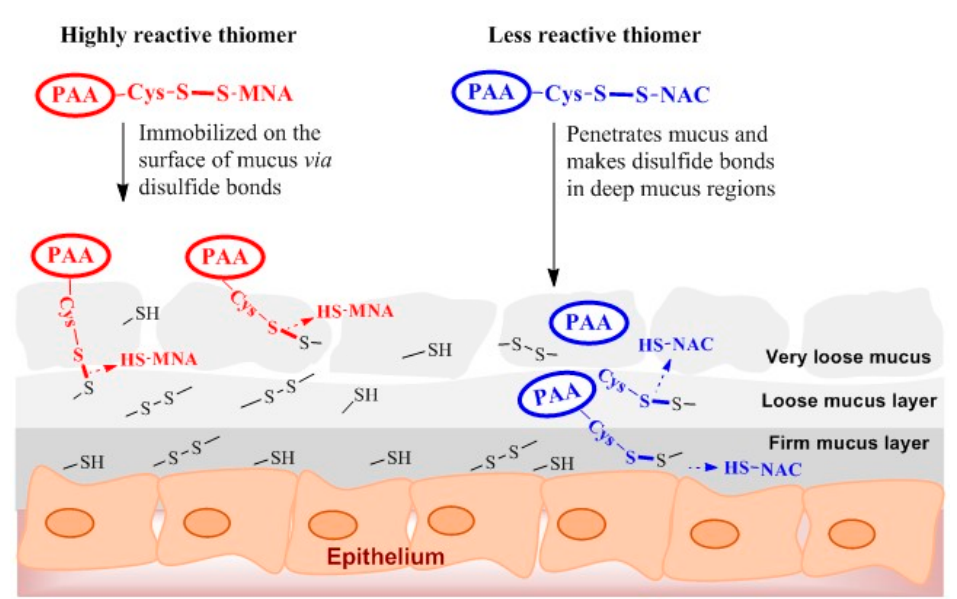
Figure 7. Viscosity of 1% m/v PAA and S-protected thiolated PAA conjugates incubated with mucus at 37 °C for indicated time points. Solutions were prepared in 50 mM phosphate buffer pH 6.8. Mucus incubated with buffer was used as control. The data are shown as mean ± SD (n = 3).